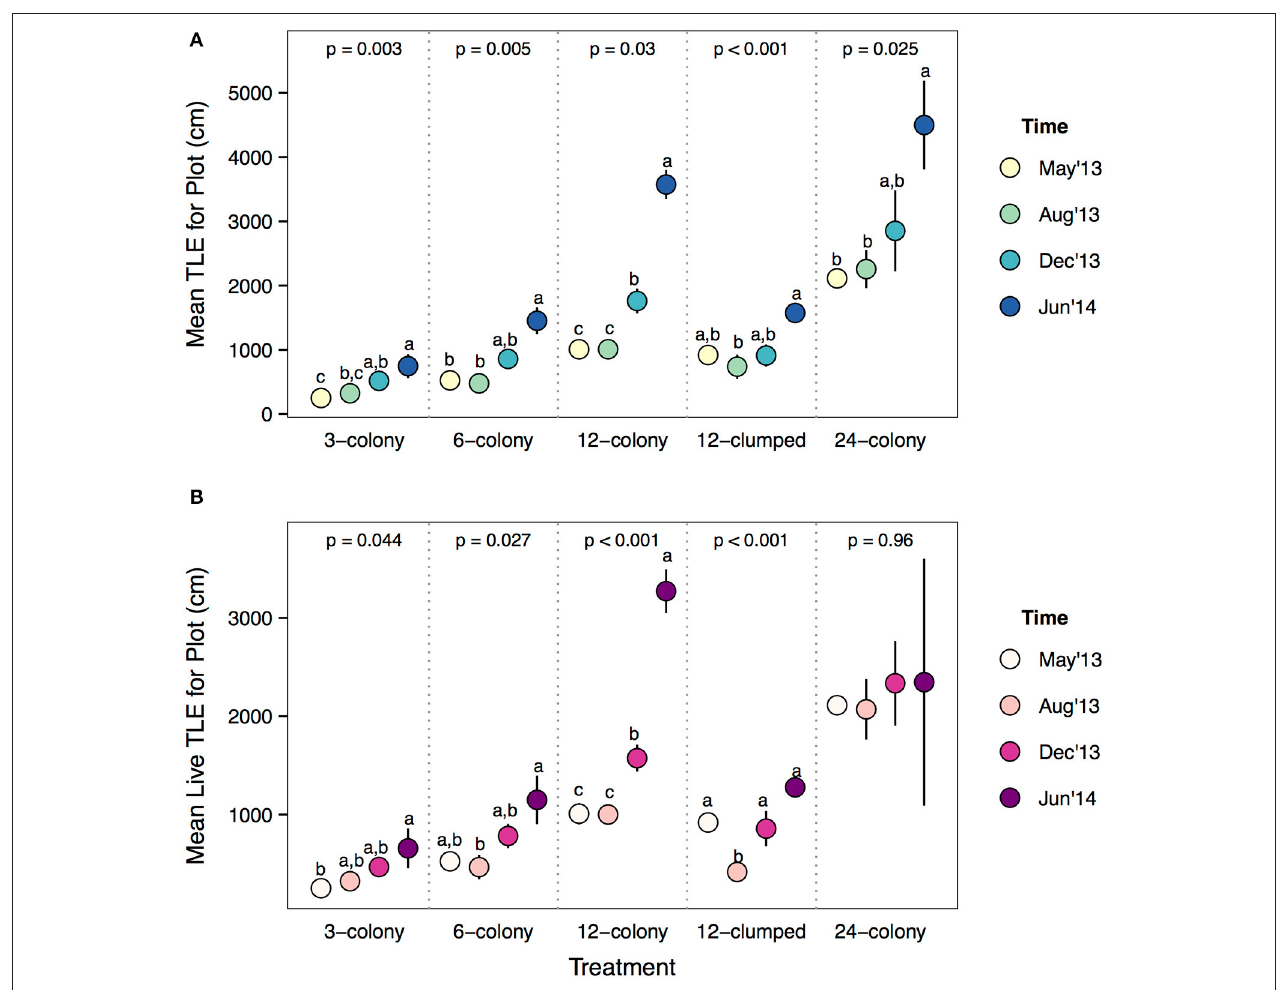
FIGURE 7 | (A) Total linear extension and (B) live TLE at the plot level comparing among survey periods within each treatment. Statistics are from one-way ANOVA. Letters represent significant differences ( p < 0.05) among time periods within a treatment from post-hoc tests with Tukey’s correction. Data are means ±